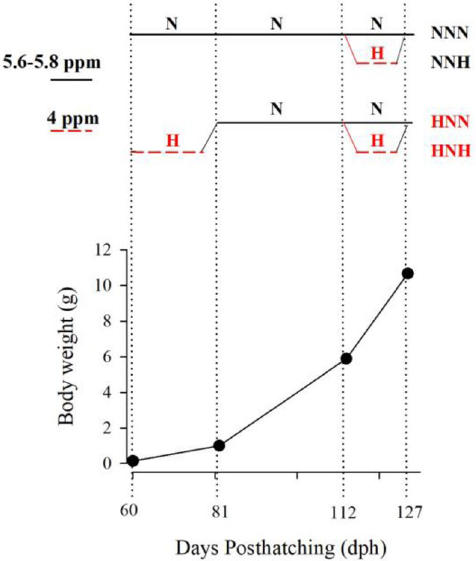
Figure 4. Experimental setup of hypoxia imprinting. Timing of normoxia (N) and hypoxia (H) exposure determines the four experimental groups: normoxic (NNN), early hypoxic (HNN), late hypoxic (NNH), and early and late hypoxic